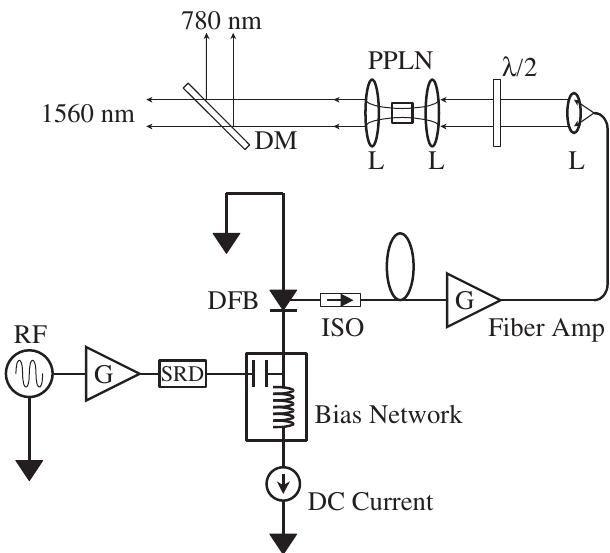
FIG. 1. Schematic of the fiber-based laser system. DFB, dis- tributed feedback Bragg reflector diode laser; ISO, fiber isolator; SRD, step recovery diode; L, lens; PPLN, periodically- poled lithium niobate frequency-doubling crystal; DM, dichroic